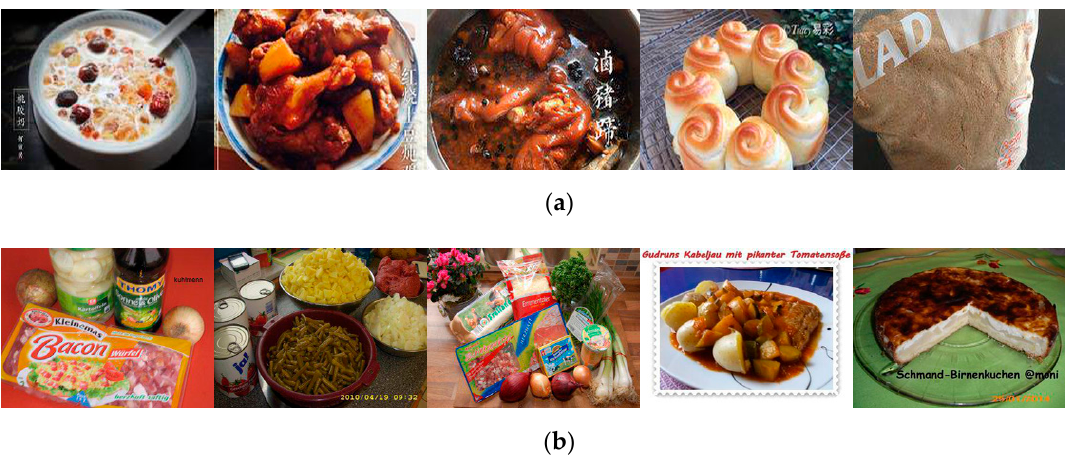
Figure 8. Examples of images with text. ( a ) Images with Chinese characters from Xiachufang.com. ( b ) Images with German characters from Kochbar.de.